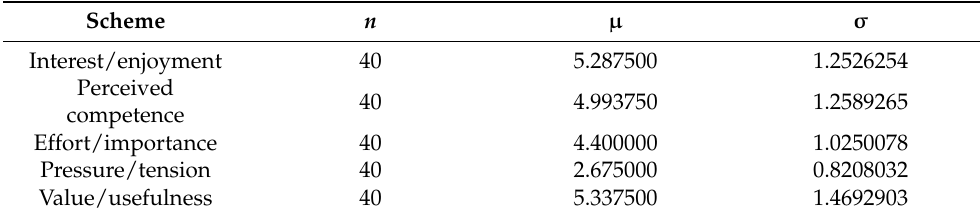
Table 9. Mean ( µ ) and standard deviation ( σ ) value of selected IMI subscales.